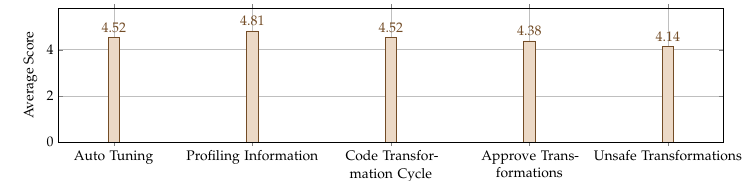
Figure 11. User feedback on proposed features for the next version of iCetus.